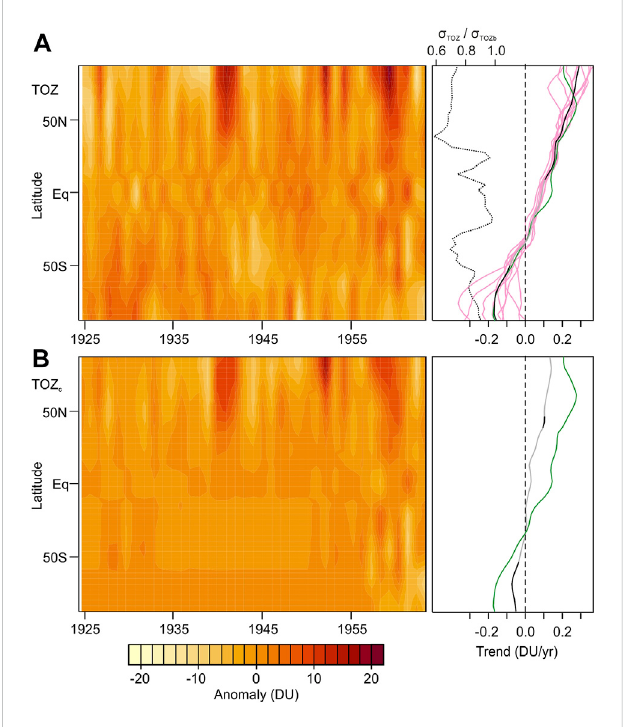
FIGURE 6 Anomalies of ensemble mean annual means of TOZ (A) and TOZ c . (B) Right: linear trends per latitude for the corresponding datasets over the 1924 – 1963 period (non-signi fi cant ( p = 0.05) in grey, signi fi cant in black,andindividualmembersforTOZinpink).TrendsforTOZ b are shown in green in both the panels. The dashed line in the upper right panelindicatesthereductionintheensemblespreadofthetrendinTOZ as compared to the prior TOZ b .